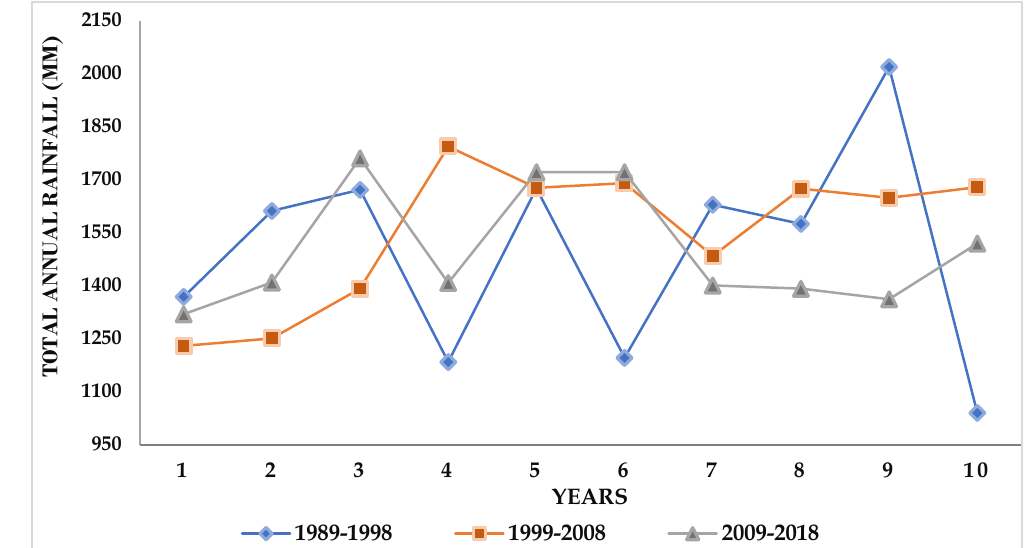
Figure 3. Total annual rainfall for Lagos (1989 to 2018).